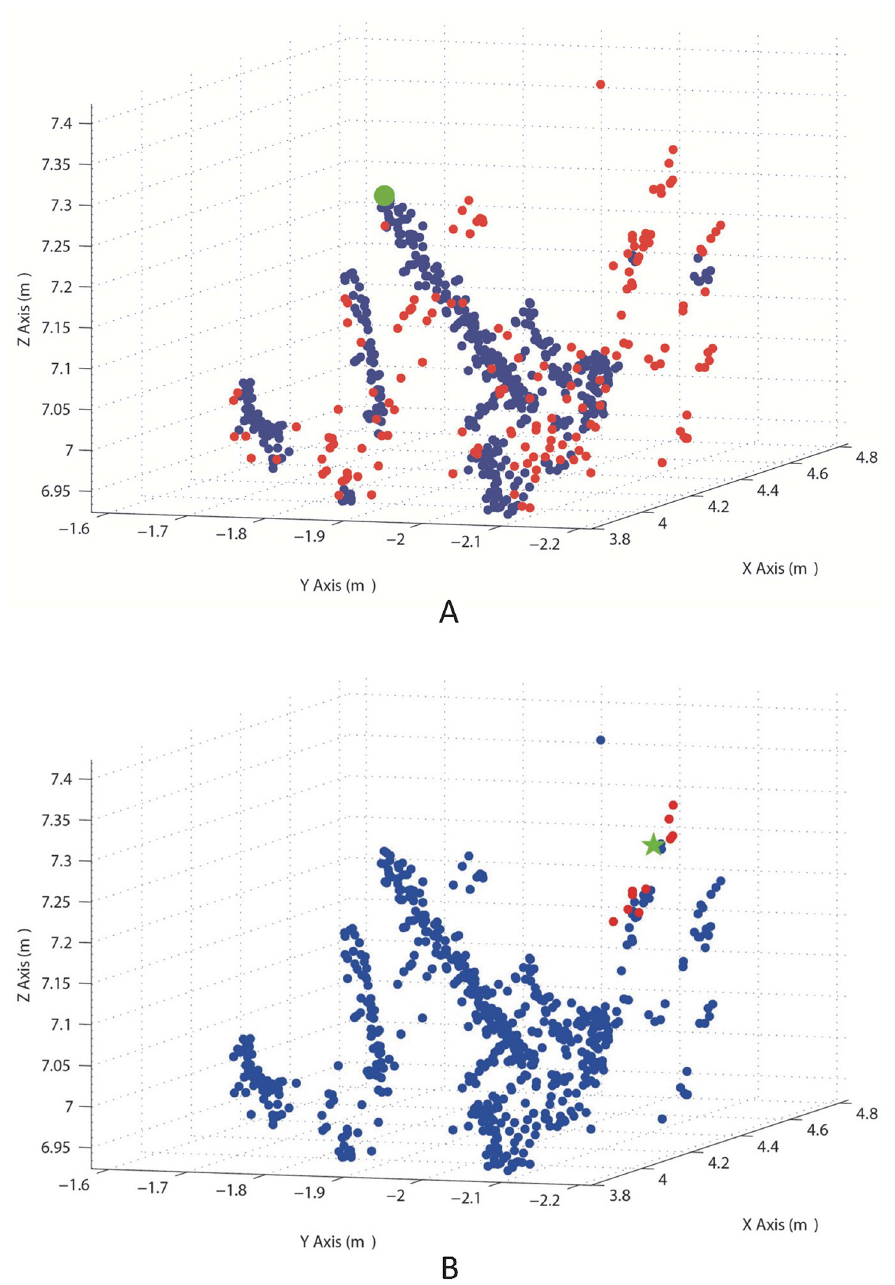
Fig 11. The process of the uppermost point definition. ( A ) An example point with its ten nearest neighbors. The green star is the example point and the red points are its ten nearest neighbors. ( B ) Two point clusters and the uppermost point. The cluster of tree points are plotted in blue. The outliers and other points are plotted in red, and the uppermost point of the tree is plotted in green with a larger size.